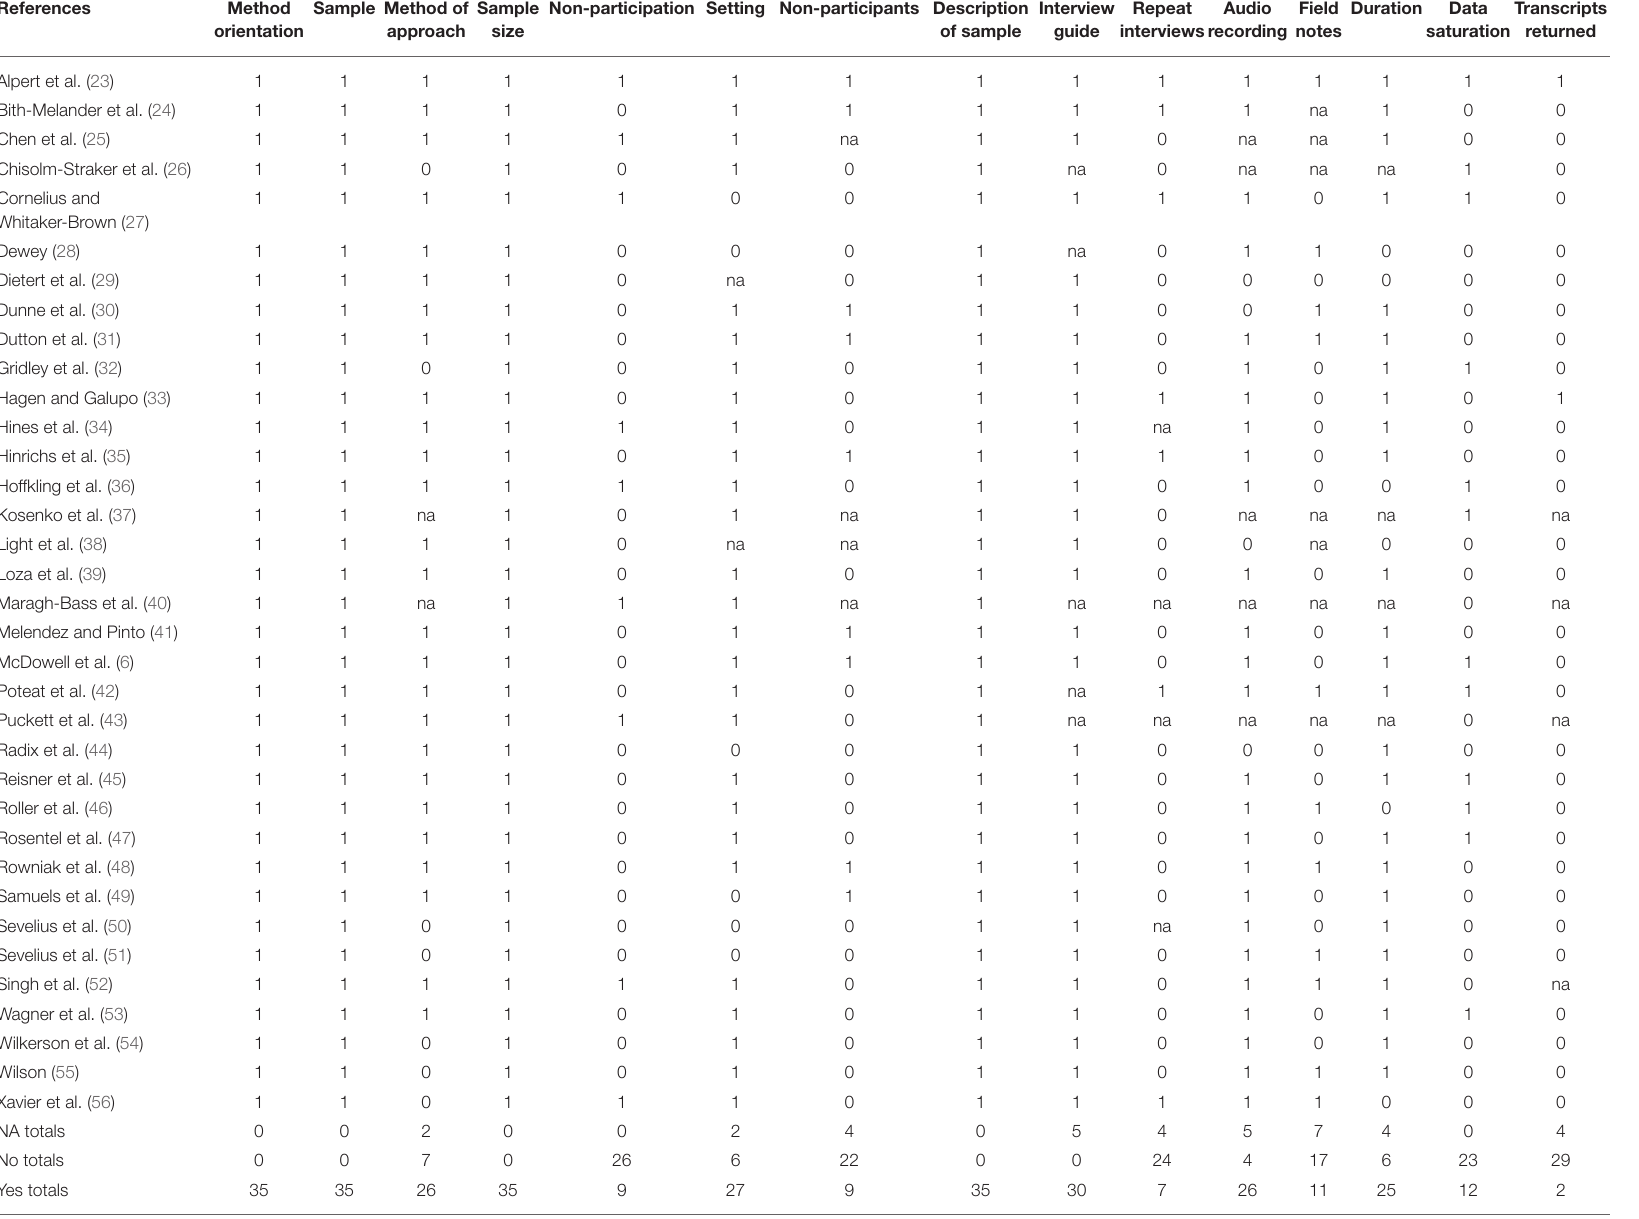
TABLE 5 | COREQ domain 2: study